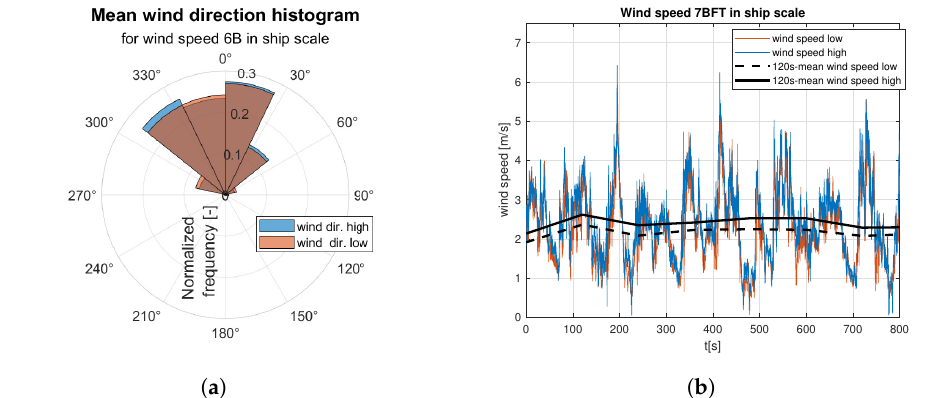
Figure 11. Raw measurements for medium weak wind—6BFT in ship scale: ( a ) wind rose; ( b ) time series. Figures 10 and 11 illustrate registered wind directions and speeds for the medium weak wind category. On 5B in ship scale wind rose (Figure 10a) main wind direction is observed and gusts from the other directions appear twice as often. On the Figure 11a a distribution of gust directions close to uniform is observed. Moreover, for the stronger winds from the medium weak category the average wind speed is close to constant (Figure 11b), in contrast to oscillating mean value presented in Figure 10b.